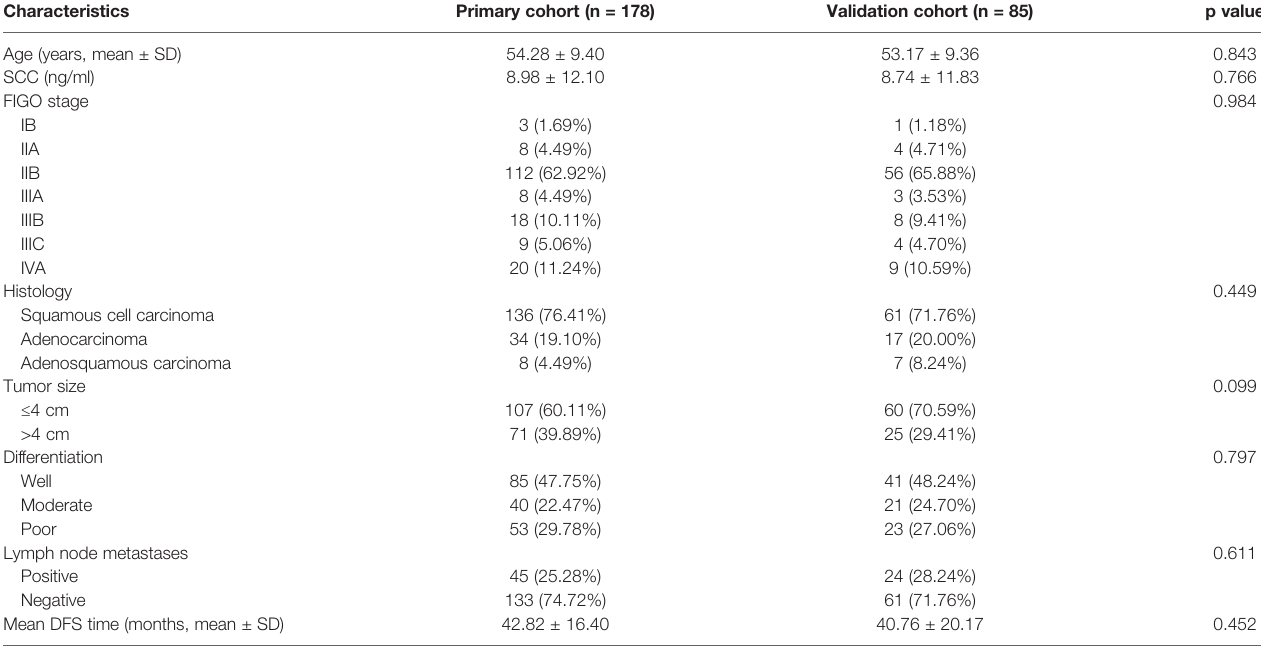
TABLE 1 | Characteristics of the patients at